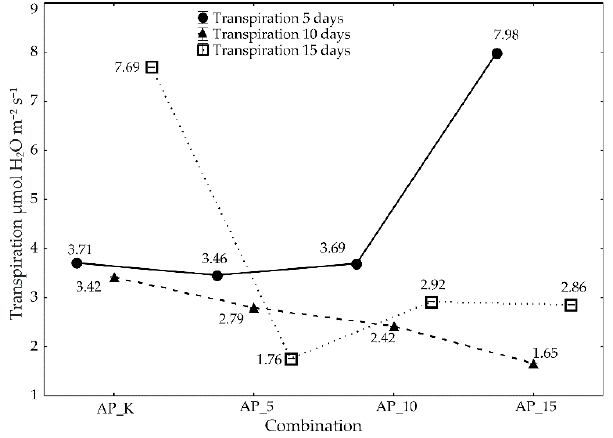
Figure 4. Intensity of transpiration in the set time intervals at pea plants with different numbers of foraging aphids of A. pisum . Vertical lines at mean values indicate SE. The highest level of transpiration in wheat exposed to R. padi , in all the quantitative variants of aphids, was achieved on the 15th day of the experiment (Figure 5). During the last